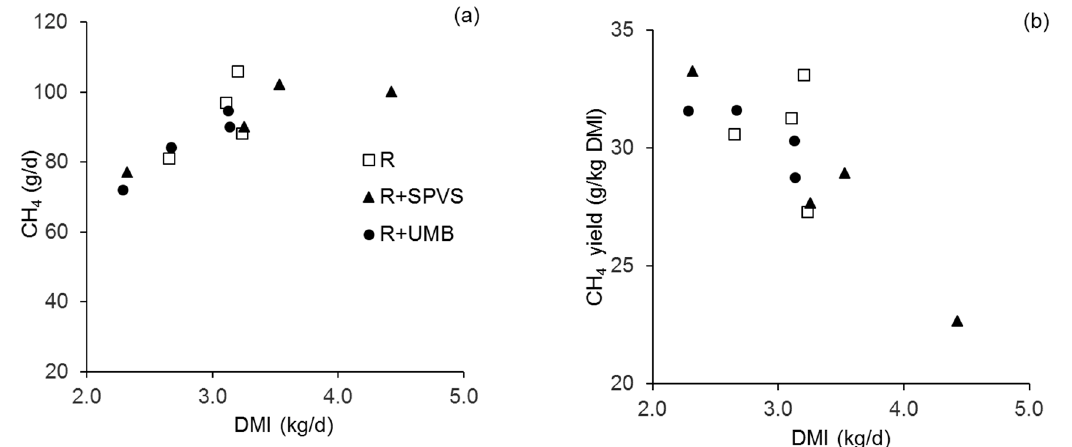
Figure 1. Relationship of the animals’ daily dry matter intake (DMI) to: ( a ) methane (CH 4 ) emissions (R 2 = 0.62); and ( b ) CH 4 yield (R 2 = 0.68). The legend in ( a ) also applies to ( b ). R, roughage (0.61 wheat straw + 0.39 Rhodes grass hay); SPVS, sweet potato vine silage: UMB, urea-molasses block; DMI, dry matter intake.